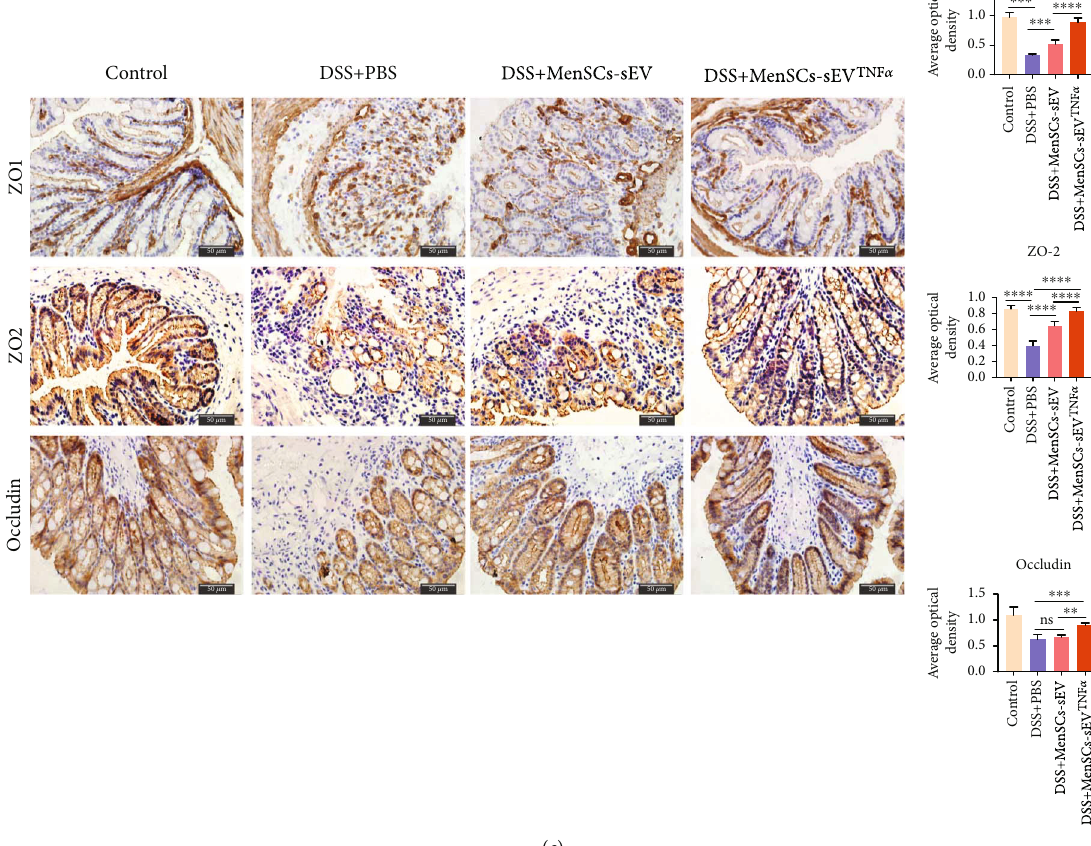
Figure 3: MenSCs-sEV TNF- α reduces the expression of proin fl ammatory cytokines and promotes the maintenance of intestinal integrity in IBD mice. (a) The levels of cytokines in the mouse colon were detected by ELISA ( n = 6 ). (b) Mice were gavaged with FITC-dextran (0.6 mg/g body weight) under fasted conditions and FITC fl uorescence intensity in serum was detected 4 hours later ( n = 6 ). (c) IHC was used to obtain optical images of the distribution and content of tight junction proteins ZO-1, ZO-2, and occludin. Original magni fi cation, × 400. ImageJ was used to quantify the tight junction proteins content in immunohistochemical